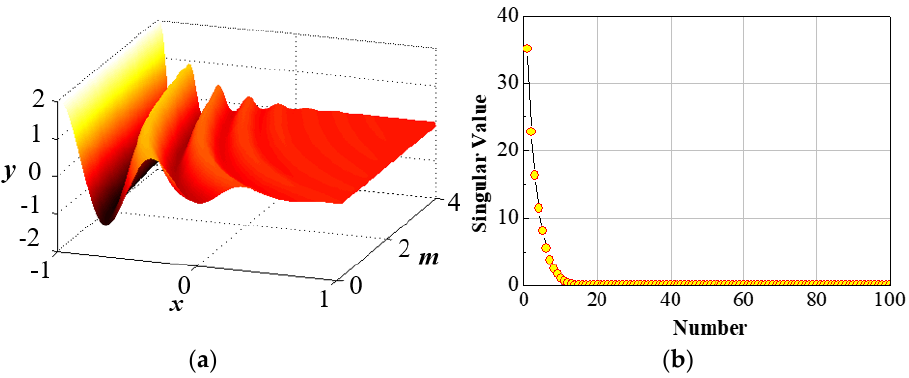
Figure 1. ( a ) Surface plot showing the distribution of y ; ( b ) Singular value energy distribution by SVD.